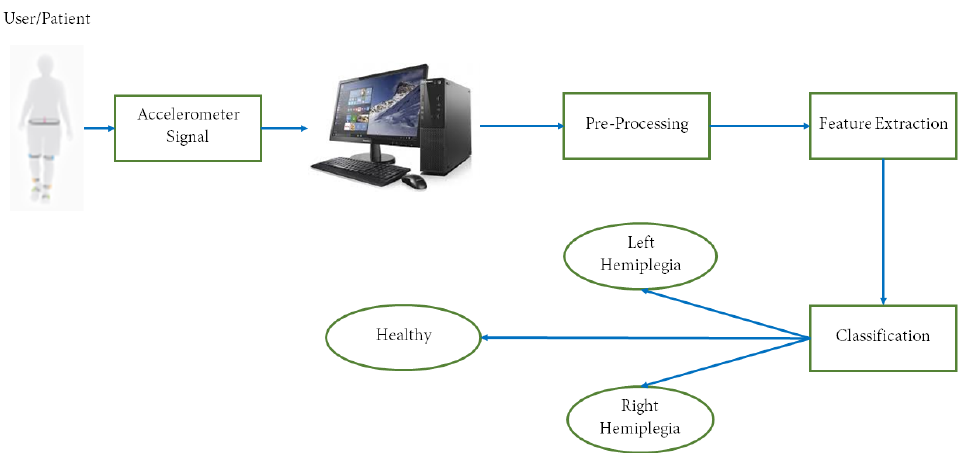
Figure 2. The system architecture. The system utilizes seven sensors placed in various body parts of the patient. The data from the accelerometer signals are received by a PC using a wireless connection and undergo a pre-processing and feature extraction procedure. Then, they introduced it as input to the FSC4RBF method, which creates optimized features that increase the classifier’s accuracy (RBFNN). Finally, the classifier categorizes the input data into three classes (healthy, left, or right hemiplegia).